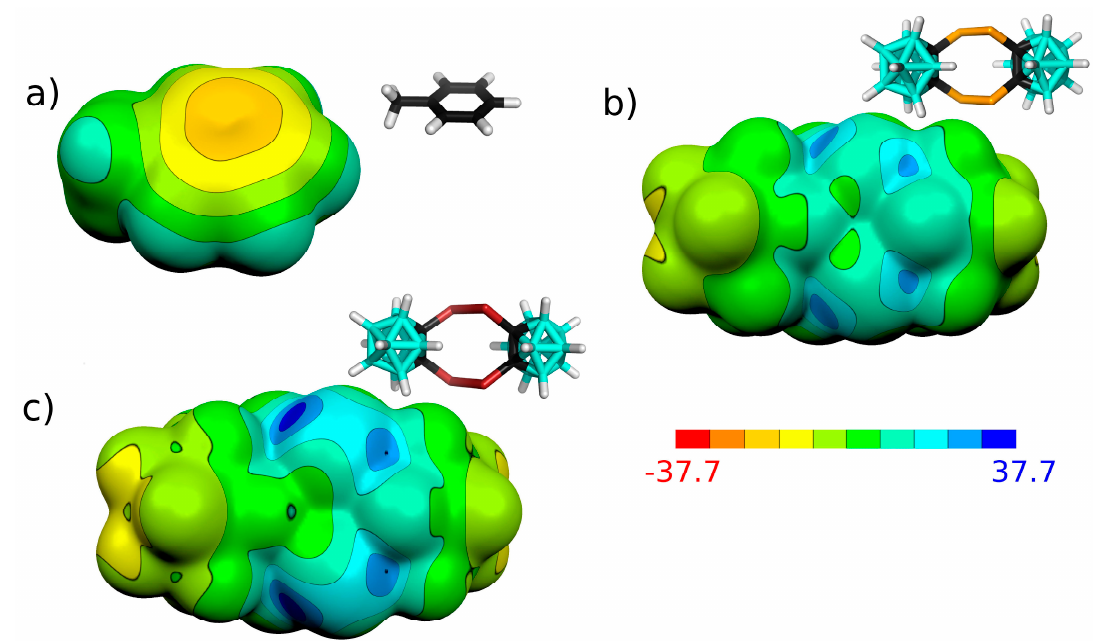
Figure 2. Molecular diagrams and computed electrostatic potential (ESP) molecular surfaces of toluene ( a ), Se 4 C 4 ( b ) and Te 4 C 4 ( c ). The ESP has been computed at the HF/def2TZVP level. The ESP color range is in kcal mol − 1 . The atom color coding is as follows: cyan—B; black—C; orange—Se; white—H; red—Te.